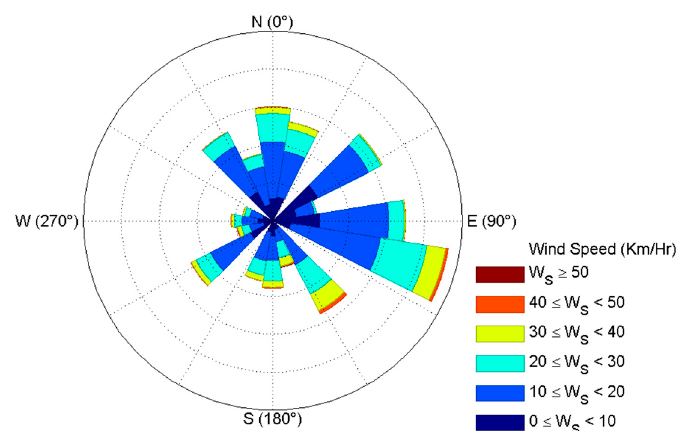
Figure 4. Wind rose (winds speed and direction average) for 2014 at the National Meteorological Service station located at Aeroparque airport (2003–2013). Source: National Meteorological Service